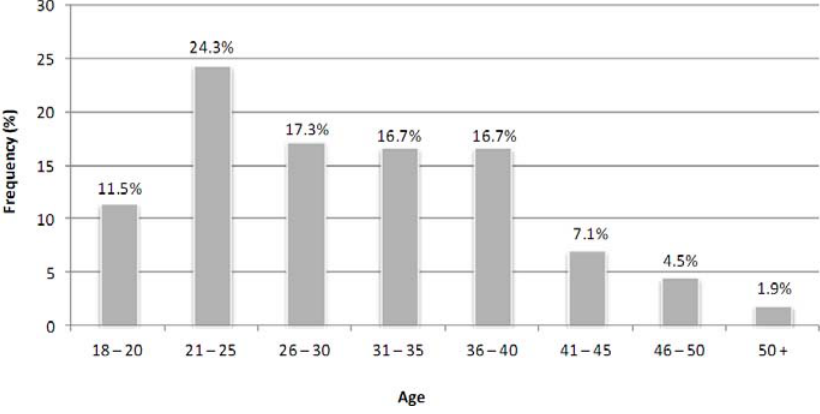
Fig. 1. Respondents’ age distribution (n =